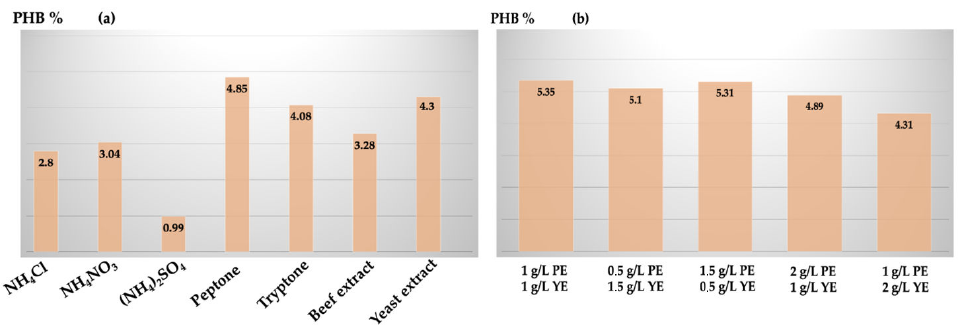
Figure 7. ( a ) Putative PHB final yield by using different nitrogen sources, and ( b ) by using peptone (PE) and yeast extract (YE) as the best nitrogen sources at different ratios.